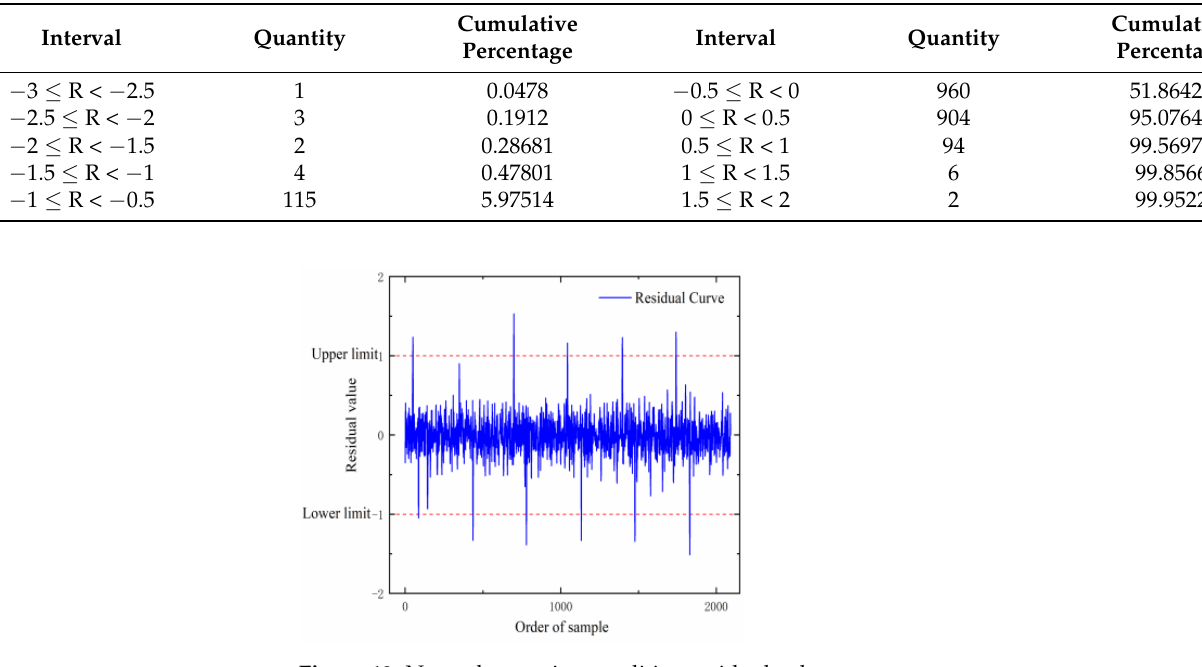
Figure 11. Distribution map of residual value under normal working conditions. Table 8. Statistical Table of Residual Values under Normal Working Conditions.